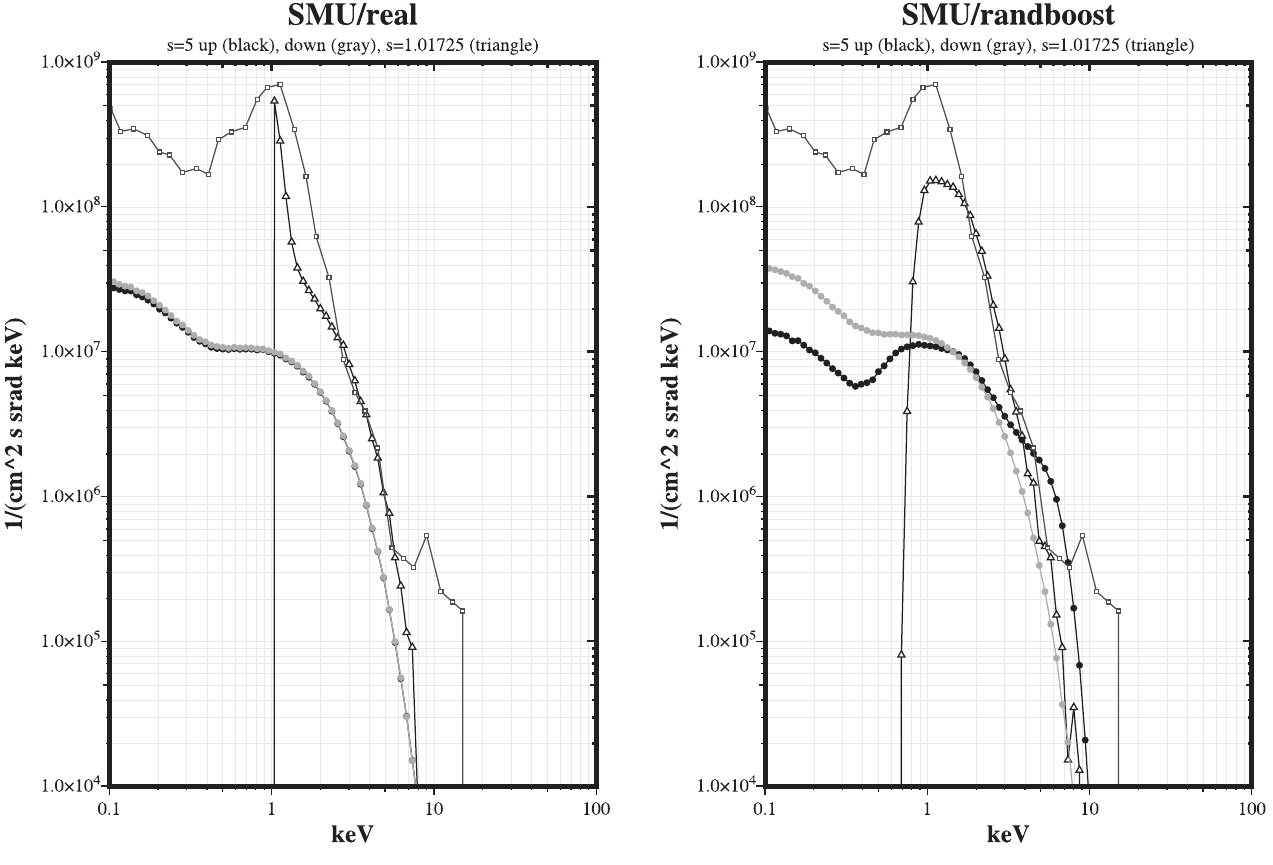
Fig. 8. SMU/real: source plasma corresponding to the dashed line in Fig. 6 accelerated through a U-shaped potential. The line marked with squares is the FAST data (the same as the dotted line in Fig. 6). The potential drop is selected to match FAST peak position (1.01 kV). The peak height is good but the peak is too narrow